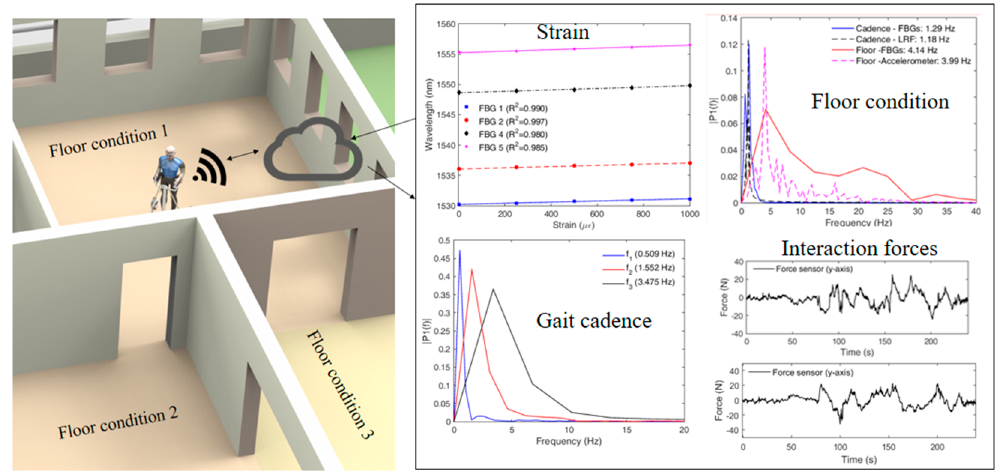
Figure 7. POF sensors on the instrumentation of smart walkers (SWs).